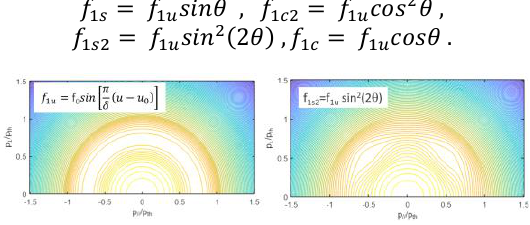
Fig. 1. Two examples of the model distribution function, perturbed isotropically (left) and anisotropically (right). Level curves in the parallel and perpendicular normalised momentum plane.